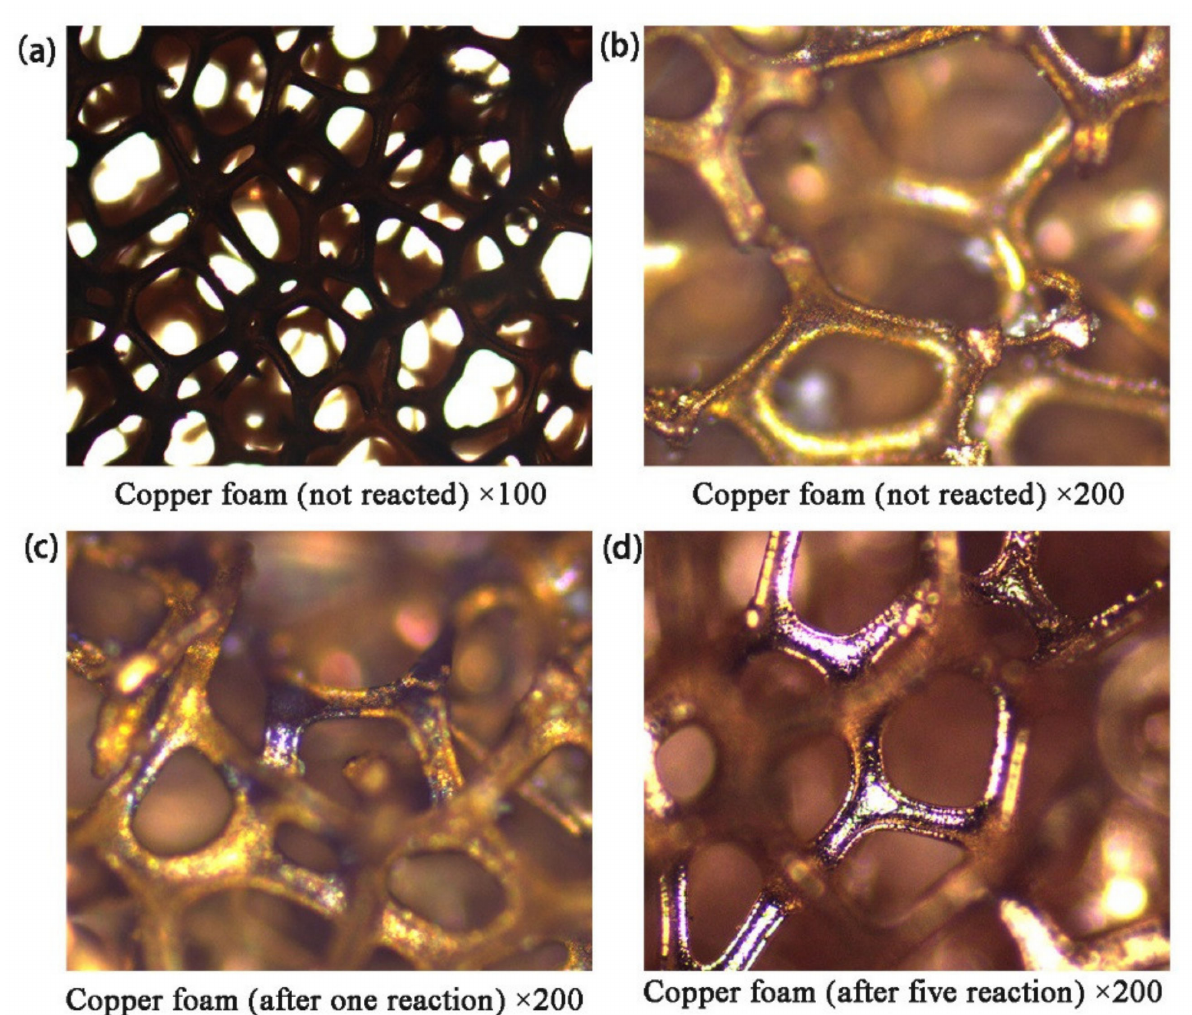
Figure 2. Morphology of copper foam under polarizing